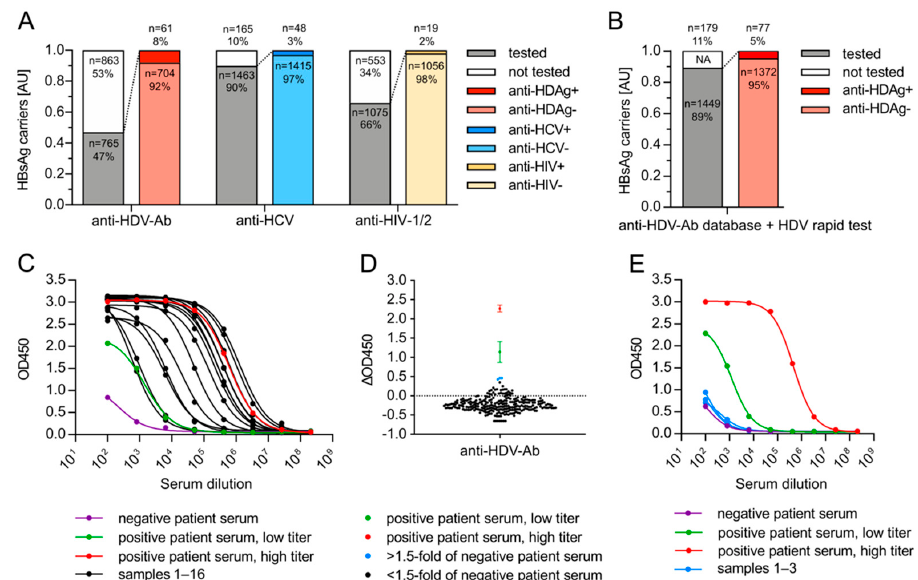
Figure 3. HDV seroprevalence in Germany. ( A ) Databank research of HBsAg-positive patients. Diagnostic testing data from 1628 HBsAg-positive patients that were admitted to the University Hospital Heidelberg between 2014 and 2019 were evaluated to determine the anti-HDV-Ab, anti-HCV, and anti-HIV 1/2 testing rates. ( B ) Testing for anti-HDV-Ab in HBsAg-positive patients. A total of 684 sera from HBsAg carriers admitted to the University Hospital Heidelberg between 2014 and 2019 with uncharacterized anti-HDV-Ab status were retrospectively tested for anti-HDV-Ab using the HDV rapid test. NA: samples for which no databank serum was available. ( C ) Validation of anti-HDV-Ab positivity. Sera that tested anti-HDV-Ab-positive using the HDV rapid test were re-tested using a standard, semi-quantitative in-house ELISA. Averaged results from three independent experiments are shown. ( D ) Testing for anti-HDV-Ab in 263 HBsAg-negative, anti-HBc-negative, anti-HCV-positive patients that were admitted to the University Hospital Heidelberg in 2019. Sera were tested for anti-HDV-Ab using an in-house ELISA. The averages of triplicate results at 1:100 dilutions are shown. Blue: sera showed equivocal ELISA signals >1.5-fold of the negative patient serum. ( E ) Re-evaluation of patient sera with equivocal anti-HDV-Ab testing results using a semi-quantitative in-house ELISA.